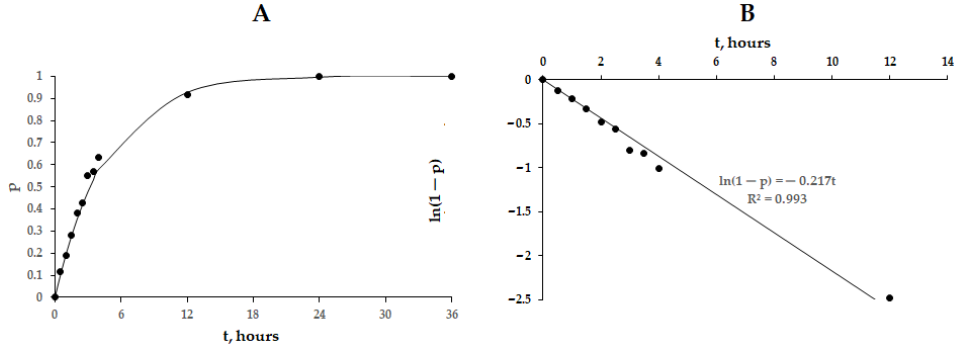
Figure 6. Release kinetics of DiI from nanosized PVP-OD aggregates: ( A ) time dependence of the DiI concentration in aqueous phase normalized to the maximum concentration. ( B ) Same data linearized by plotting ln ( 1 − p ) vs. t . Solid lines in both panels show a fit of the experimental data to a first order kinetic equation with a rate of 0.217 h -1 .